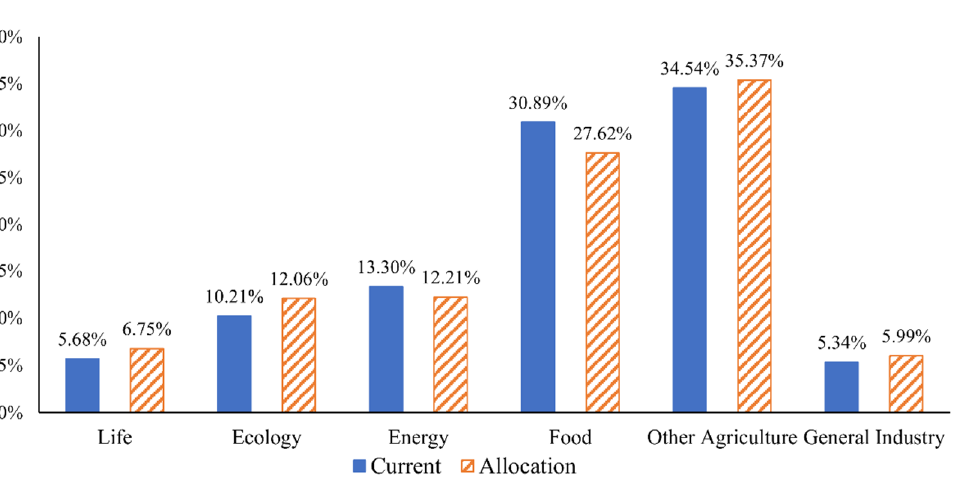
Figure 4. Comparison of the percentage of current water rights and allocated water rights in various industries.